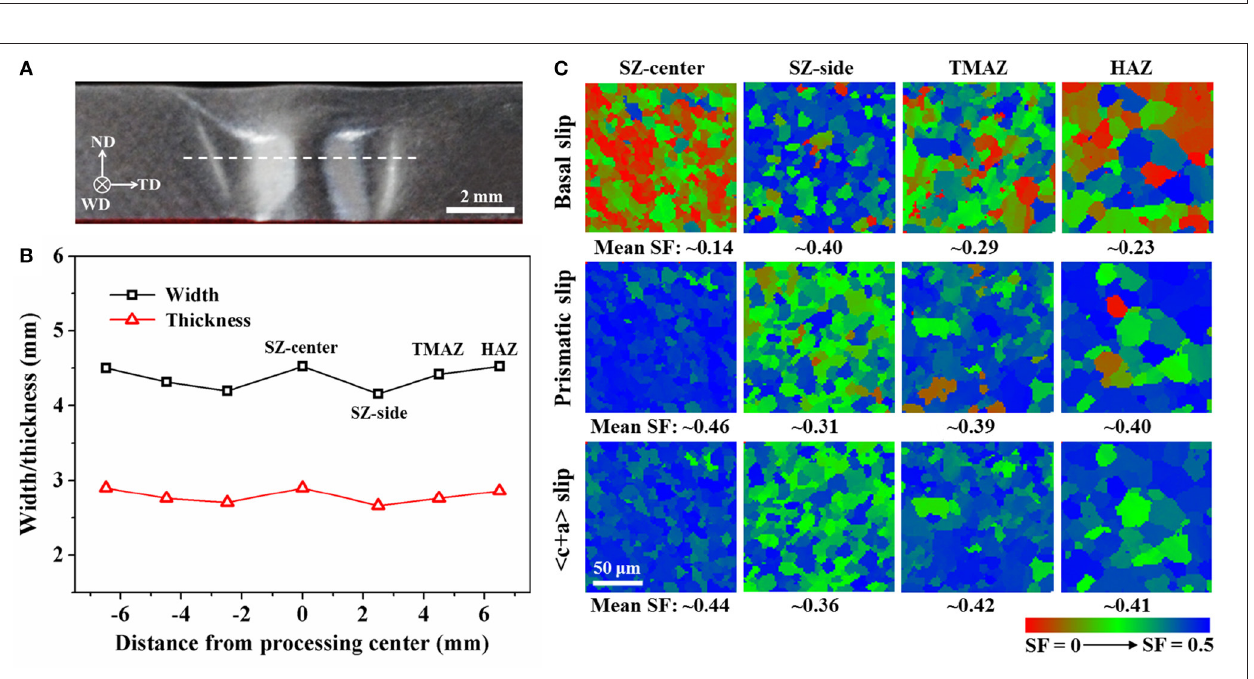
FIGURE 4 | Summary of the mechanical properties of FSW Mg alloys: (A) YS and (B) UTS.